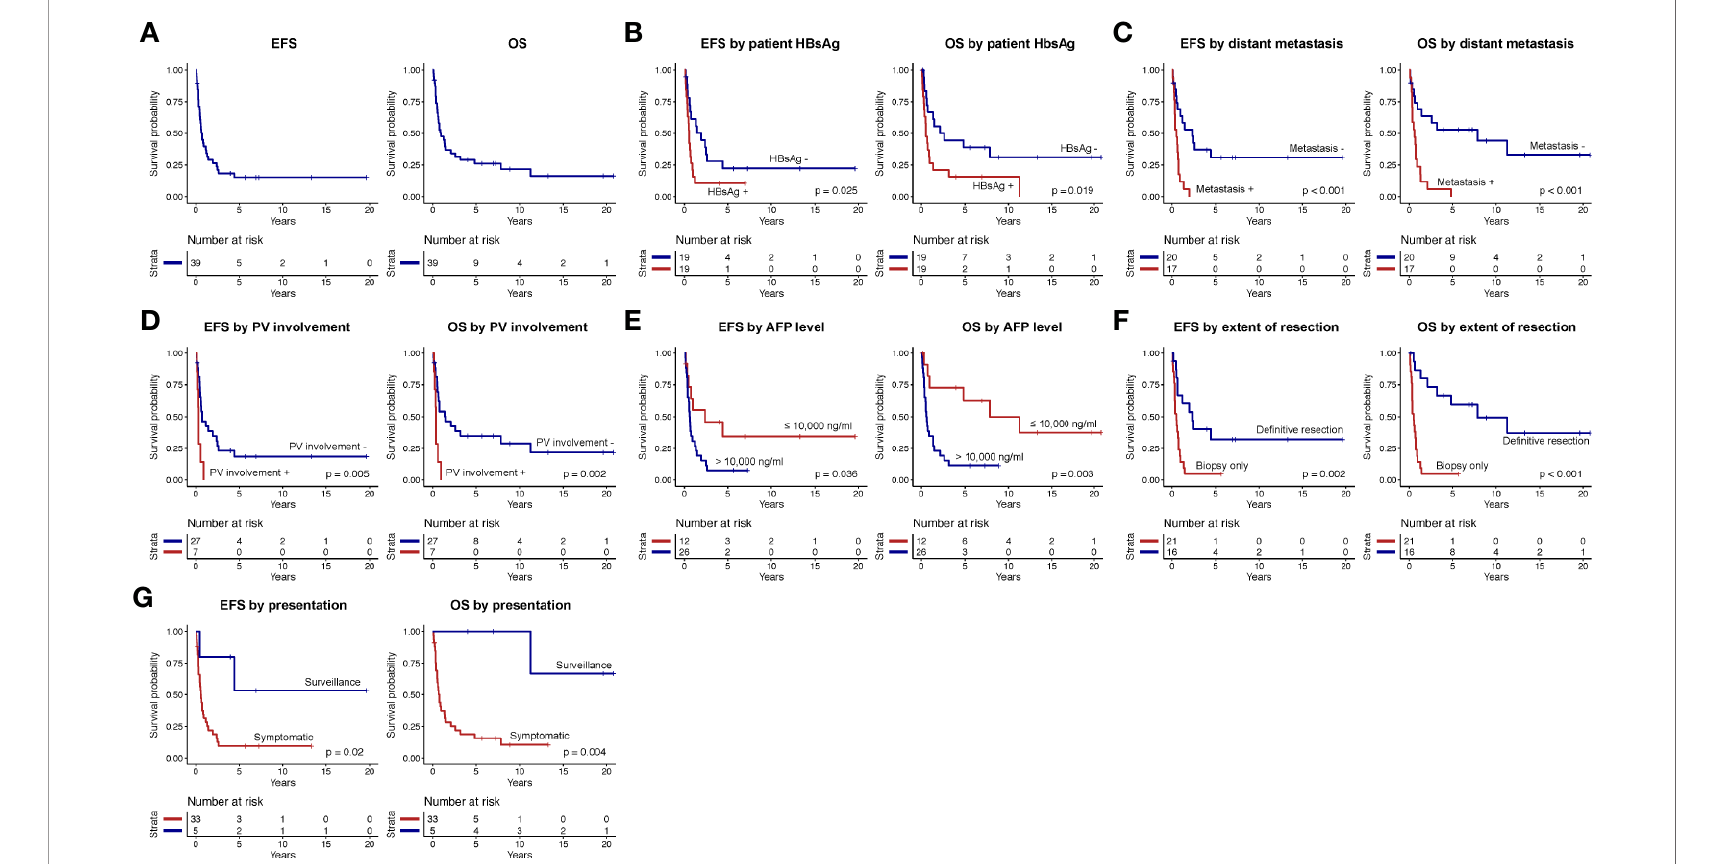
FIGURE 3 | Event-free survival (EFS) and overall survival (OS) of (A) the entire study cohort, according to (B) patients ’ hepatitis B surface antigen (HBsAg) serostatus, (C) presence or absence of distant metastasis, (D) portal vein (PV) involvement, (E) alpha-fetoprotein (AFP) level, (F) extent of resection, and (G) mode of presentation (surveillance versus